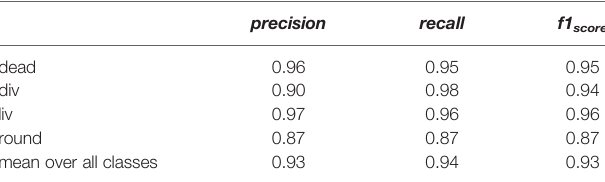
TABLE 1 | Evaluation of the classi fi cation by a simple CNN on the upsampled dataset. precision